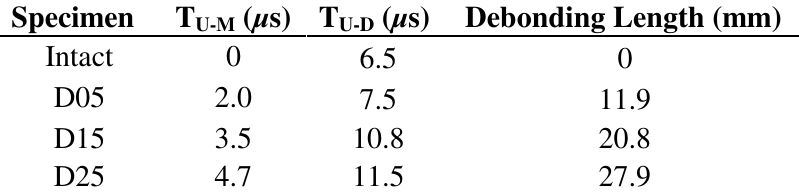
Table 3. Time delay and estimated debonding